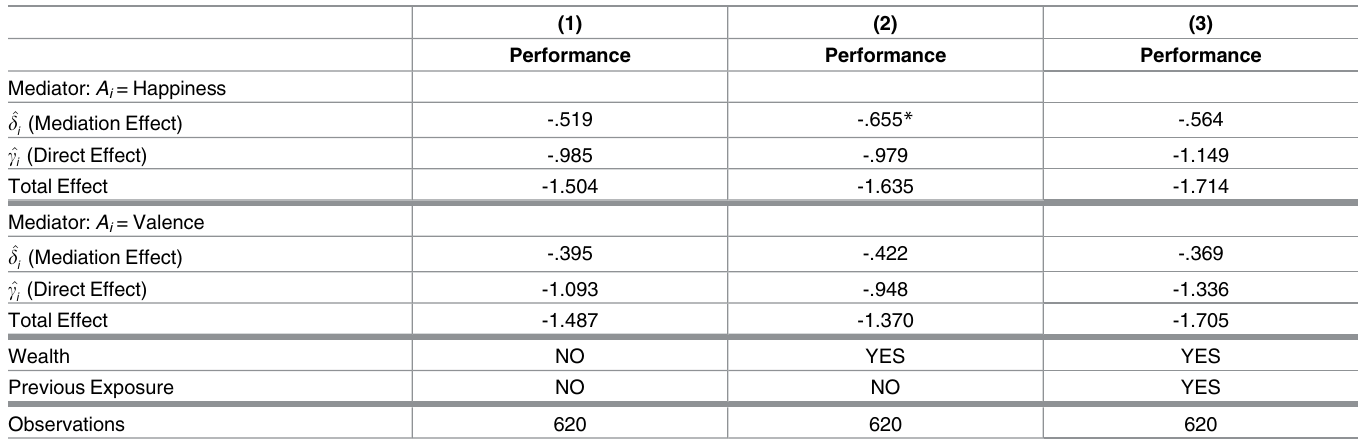
Table 10. Mediation Analysis Table for the Physiological Variables of Happiness and Emotional